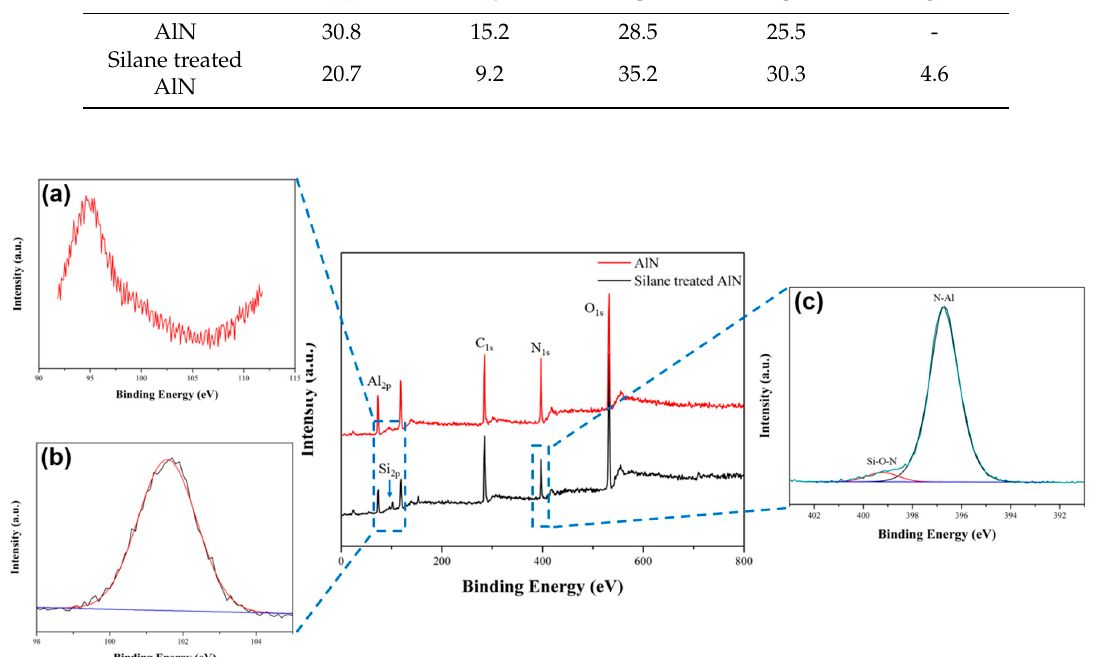
Figure 3. XPS spectra of the AlN and silane treated AlN. ( a ) Si 2p peak of the AlN; ( b ) Si 2p peak of silane treated AlN; and ( c ) N 1s peak of the silane treated AlN. Table 2. Relative percentages of elemental composition of the AlN and silane treated AlN. Sample